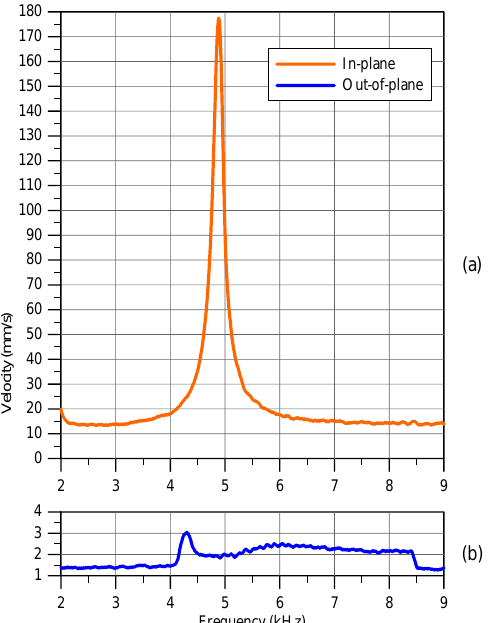
Figure 7. Frequency-response curves of the actuator under the excitation waveform V o = 7.5V as the frequency is swept from 2kHz to 9kHz. ( a ) in-plane measurements, and ( b ) out-of-plane